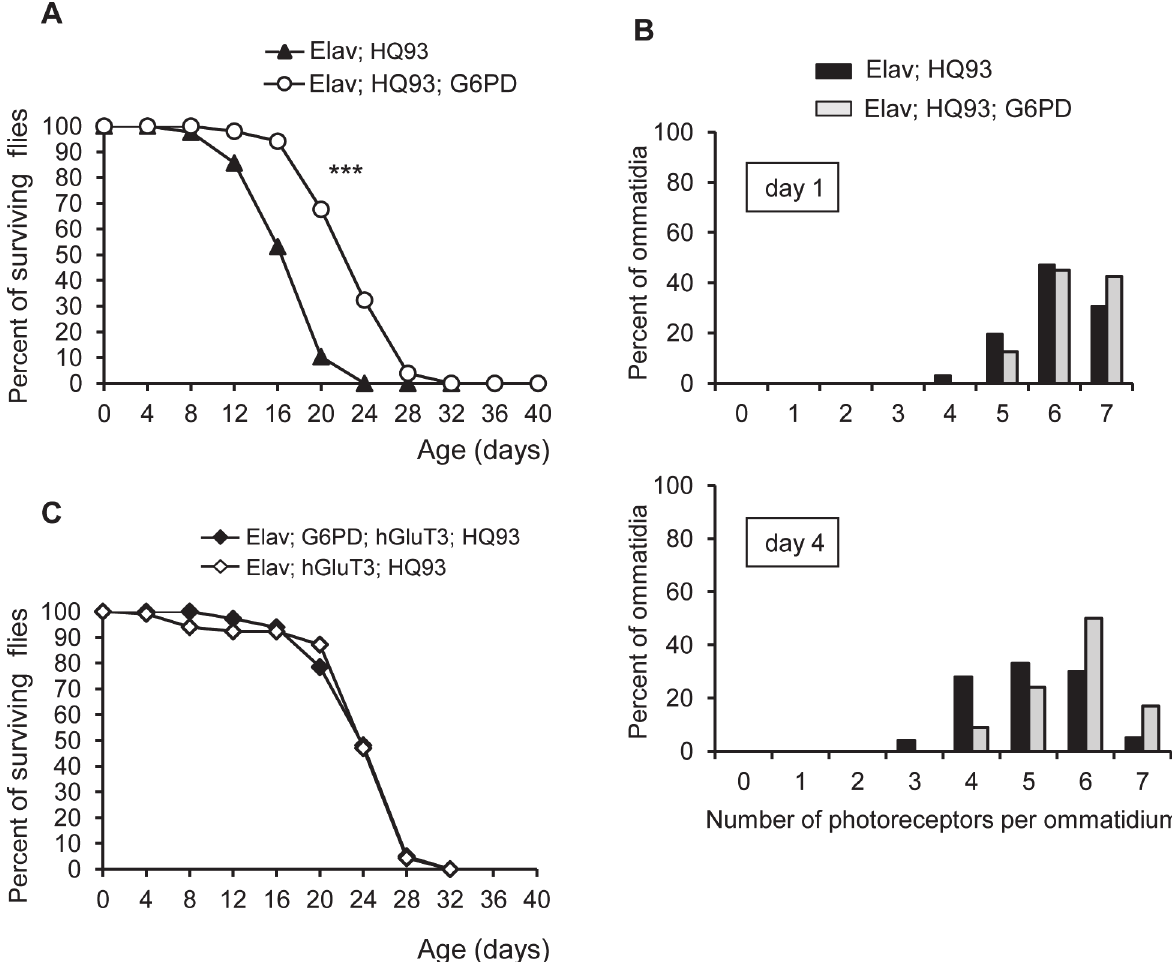
Fig 4. Effect of overexpression of G6PD on the phenotype of HQ93 flies. ( A ): Lifespan of flies carrying two neuronal transgenes G6PD and HQ93 (open circles) was extended in comparison with flies carrying only HQ93 (filled triangles) with Elav- Gal4, n = 102 and 126 flies respectively. Survival curves were highly significantly different by log-rank test ( *** , p < 0.0001). ( B ): Photoreceptor frequency distributions in 1- or 4-day old flies expressing HQ93 alone (black bars), or G6PD and HQ93 (grey bars). The median value of photoreceptor number per ommatidium between the two lines was statistically significant at the 1 st and 4 th day after adult emergence (Mann-Whitney test; at day 1, p = 0.0104; at day 4, p < 0.0003). ( C ): Lifespan of HQ93 flies carrying hGluT3 and G6PD (filled diamonds) was not different from the lifespan of HQ93 flies carrying only hGluT3 (open diamonds) with Elav- Gal4, n = 117 and 181 flies